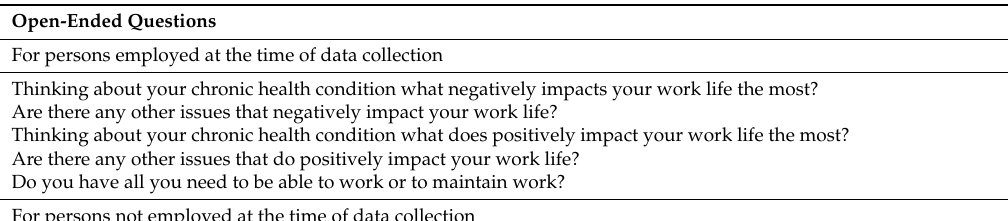
Table 1. Open-ended questions of the online survey (English